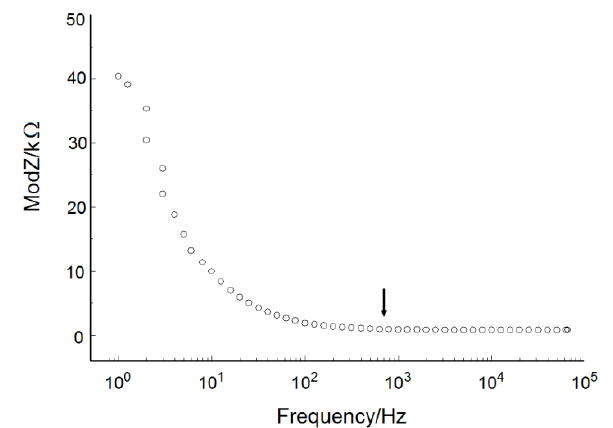
Fig. 2: Magnitude of Z vs. frequency. The black arrow indicate the working